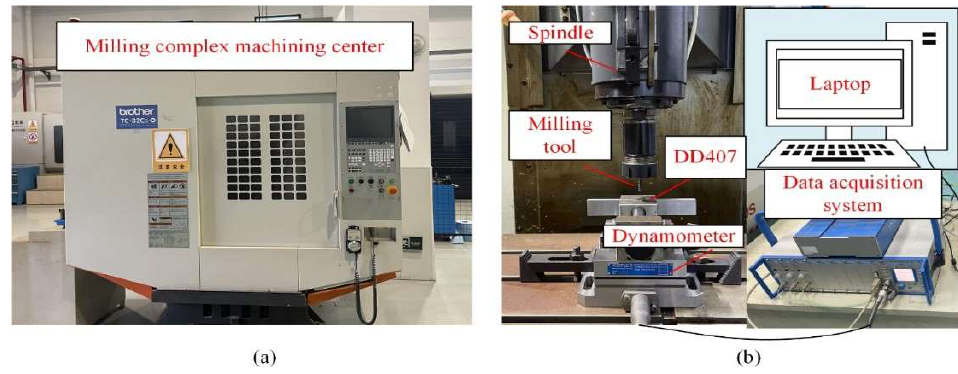
Figure 2. ( a ) The milling complex machining system and ( b ) the text system.